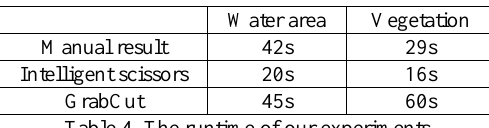
Table 4. The runtime of our experiments